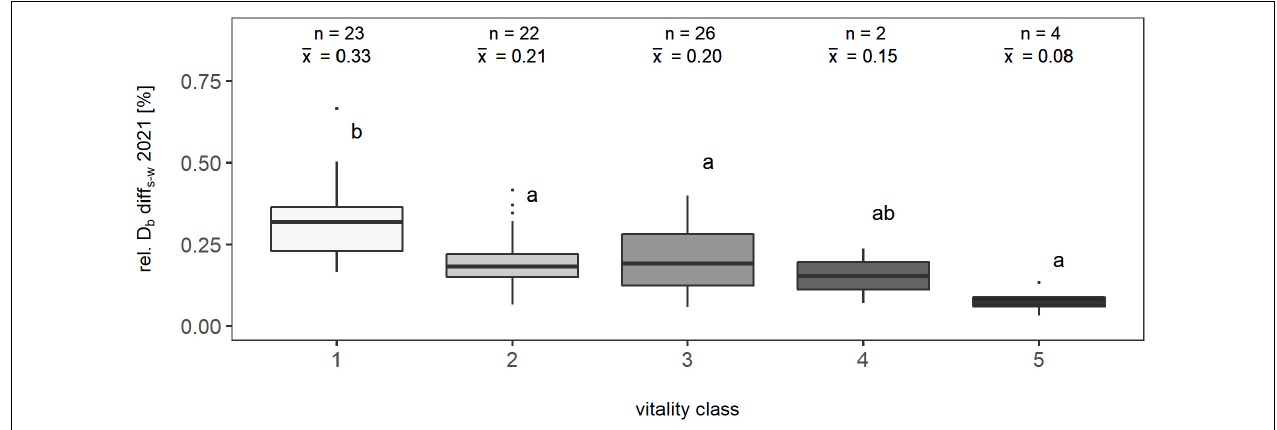
FIGURE 6 | Relationship between the percentage difference of the box-dimension between summer and winter of one year (2021) and a visual classification of trees into vitality classes based on their percentage of crown defoliation for a total of 77 observations; “n” represents the number of observations, and “¯x” represents the arithmetic mean value of the respective class. Means that do not share a common letter are significantly different by Dunn’s test at a 5% significance